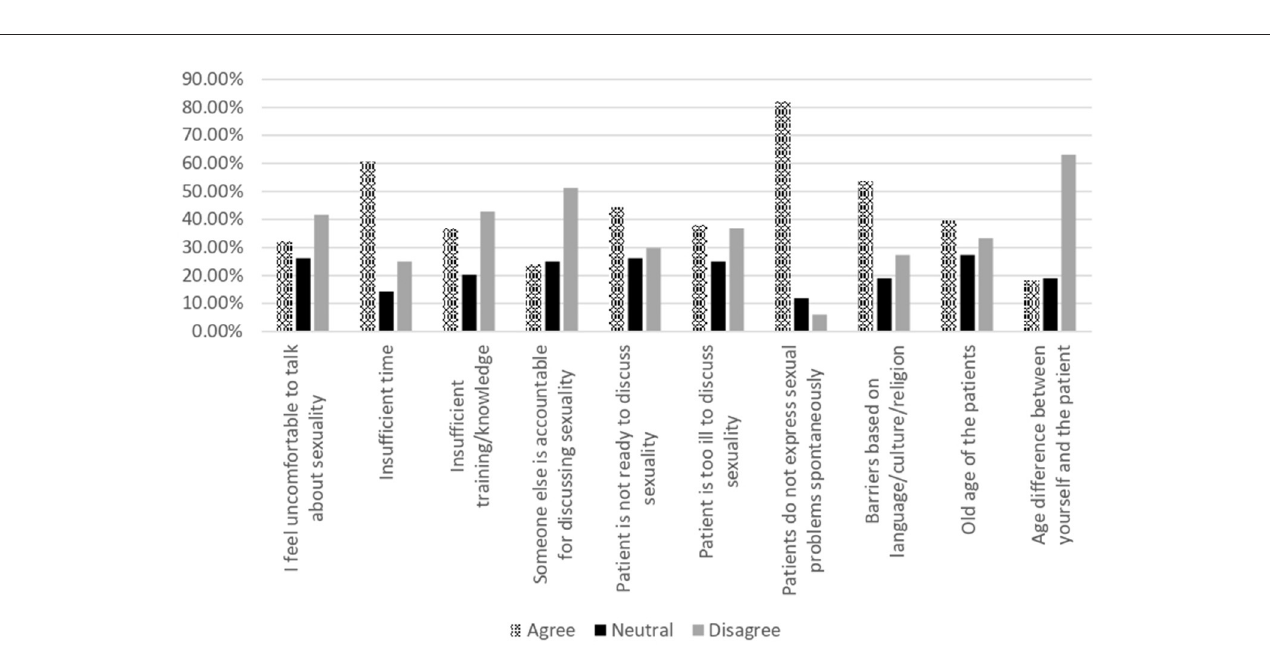
FIGURE3 Barriers toward discussing